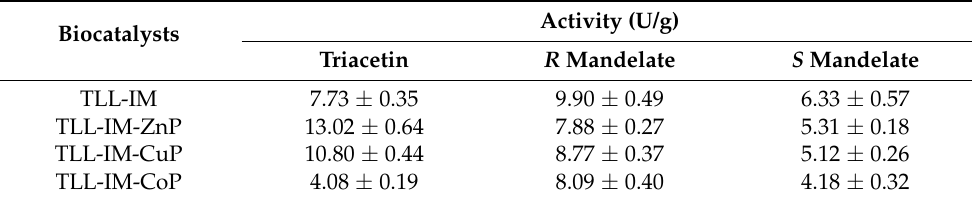
Table 1. Specific activity of different biocatalysts with 50 mM R - or S -methyl mandelate (pH 7, 25 ◦ C) and 50 mM of triacetin (pH 7, 25 ◦ C). Experiments were performed as described in the Methods section.